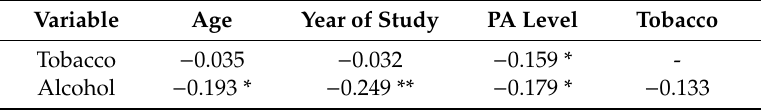
Table 2. Correlation coe ffi cients of study variables.